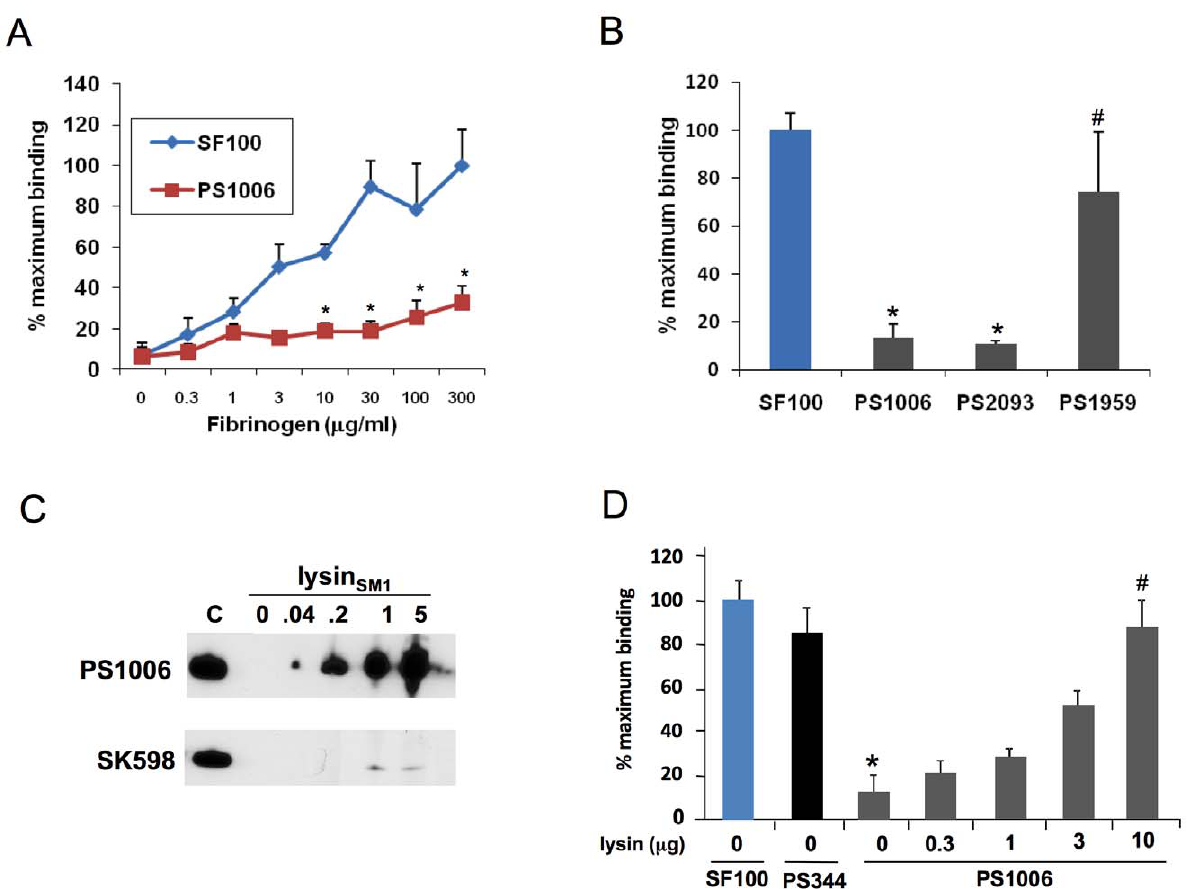
Figure 6. Lysin mediates binding of bacteria to fibrinogen. (A) 10 6 CFU of SF100 or PS1006 were incubated with wells pretreated with the indicated concentrations of fibrinogen. Values represent percent of SF100 binding to wells treated with 300 m g/ml fibrinogen. (B) Complementation of the lys mutant (PS1006) with the lys gene in trans assessed by measuring S. mitis binding to immobilized human fibrinogen. PS1959 (PS1006 complemented with lys ) demonstrated significantly greater levels of binding (P , 0.05) than PS1006 or PS2093 (PS1006 complemented with pDE123 control vector). Levels of fibrinogen binding by PS1959 were comparable to those seen with SF100 (P . 0.05). (C) Binding of FLAG lysin SM1 to PS1006, but not SK598. Bacteria were incubated with purified lysin SM1 , and lysin SM1 bound to the cell wall was detected with anti-FLAG antibody. Lane C contains purified lysin SM1 (0.2 m g/ml) as a positive control. (D) PS1006 was incubated with immobilized fibrinogen in the presence of indicated concentration of purified FLAG lysin SM1 ( m g/ml). Values represent percent of SF100 binding, and are the means of triplicate results from a representative experiment. * =P , 0.05 compared with SF100; # =P . 0.05 compared with PS1006.